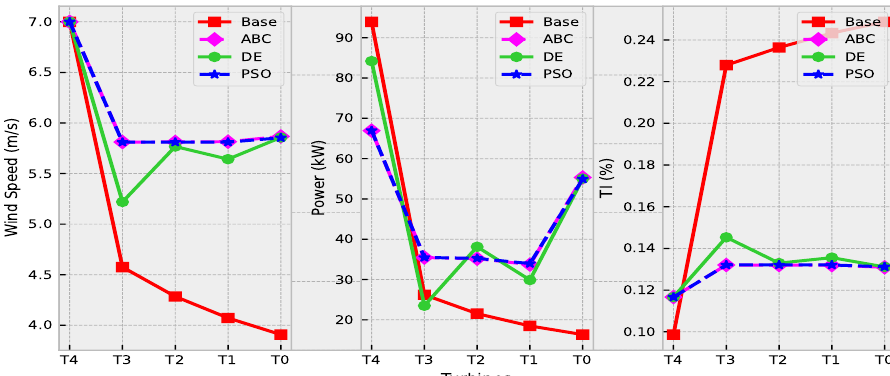
Figure 8. 5 D deployment distance at 7 m/s mean wind speed.